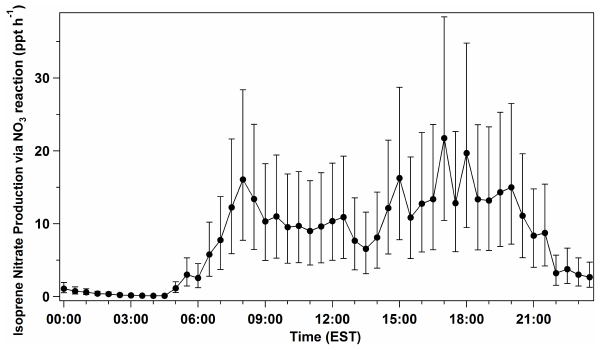
Fig. 6. Modeled diurnal cycle of primary isoprene nitrate produc- tion via reaction of NO 3 with isoprene at ∼ 12m above the forest canopy. Error bars represent sensitivity to emission rate uncertain- ties and